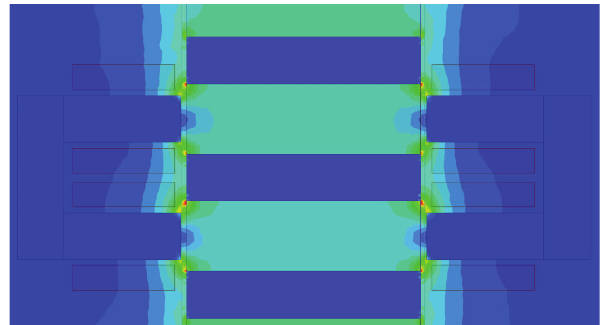
Figure 34: Magnetic field intensity at 𝑡 = 20 ms.